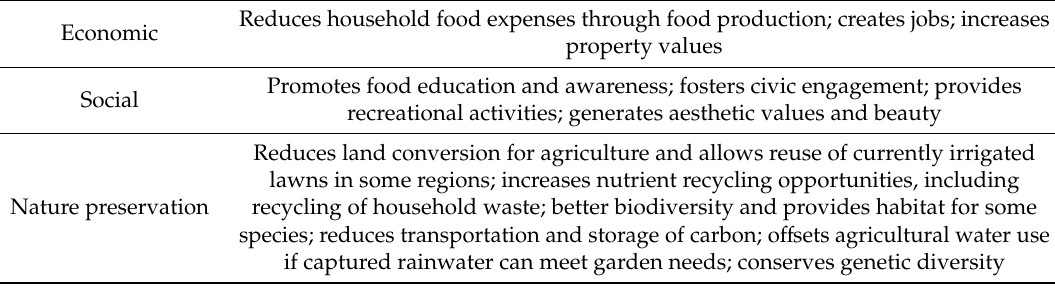
Table 2. Examples of nonfood-related benefits from urban